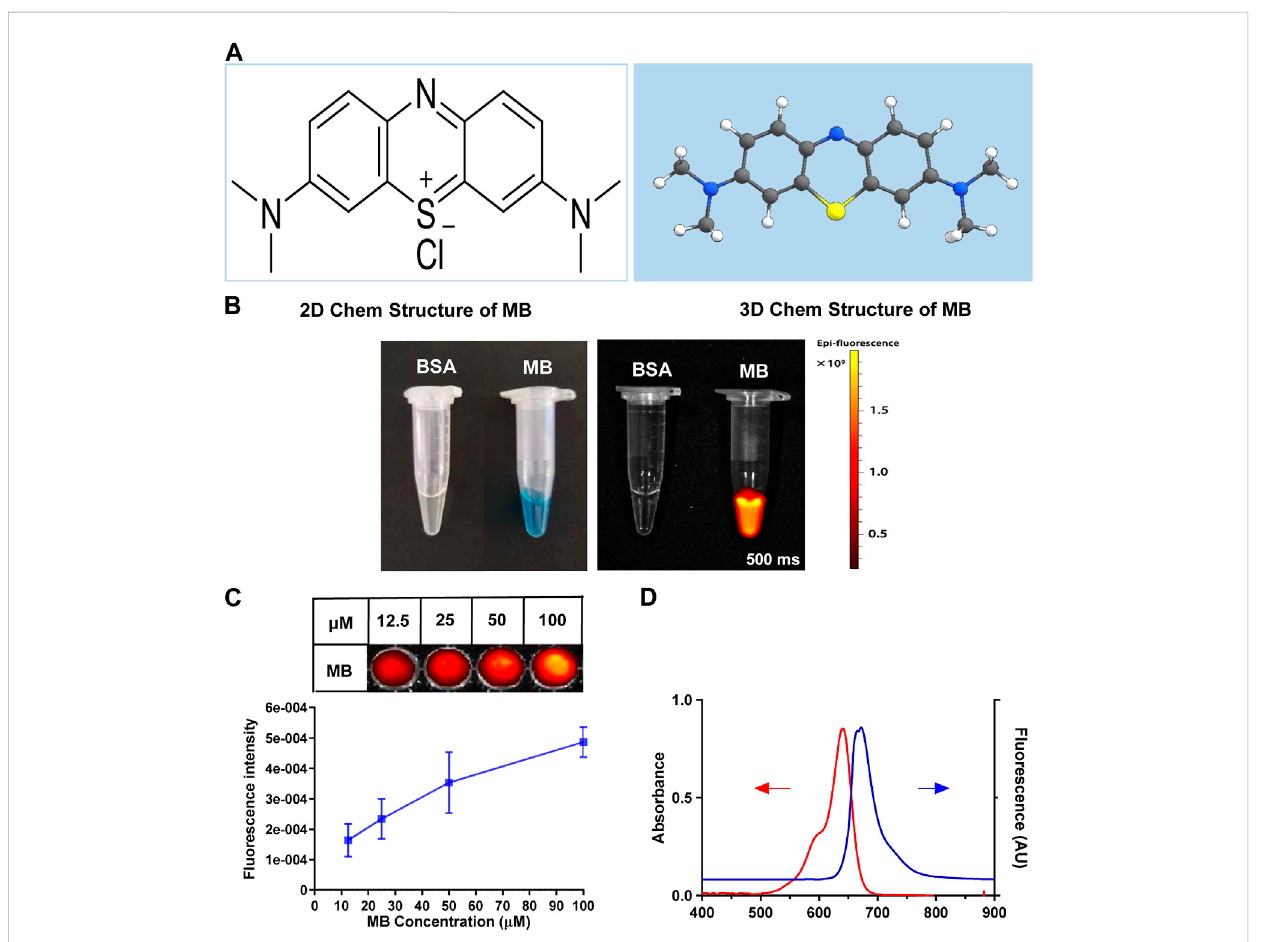
FIGURE 1 Structural characteristics and optical properties of MB. (A) 2D and 3D chemical structure of MB. (B) Optical properties of MB in 10% bovine serum albumin (BSA, 100 µM) were observed under the NIR fl uorescence imaging system. (C) The fl uorescent intensity of MB in 10% BSA (12.5, 25, 50,